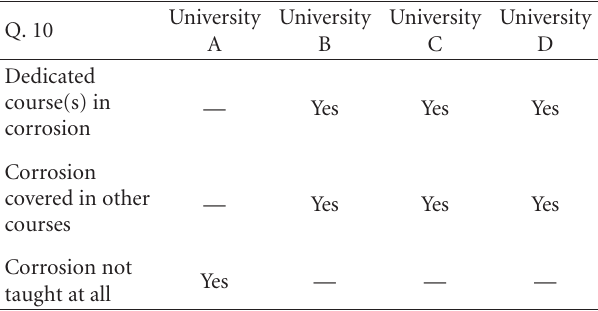
Table 3: Level of existing engineering corrosion curricula